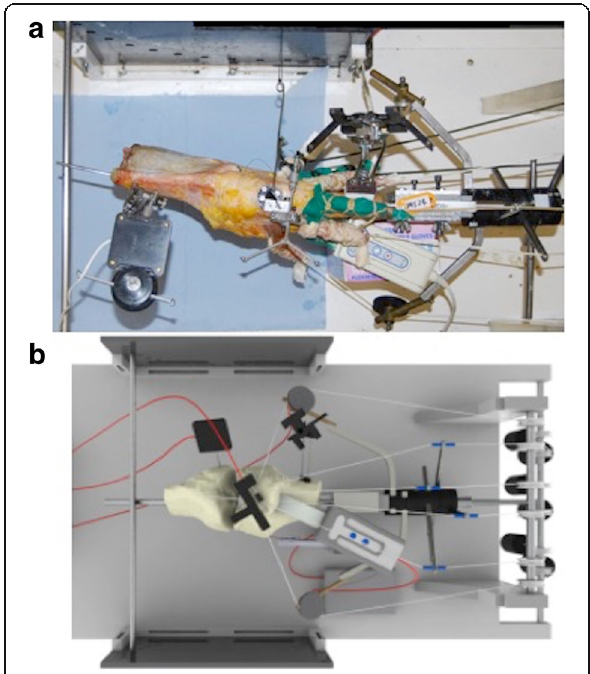
Fig. 1 a , b : photograph and schematic of the test rig, showing multiple loading cables attached to the muscles and ITB, plus optical trackers mounted on the femur, tibia and